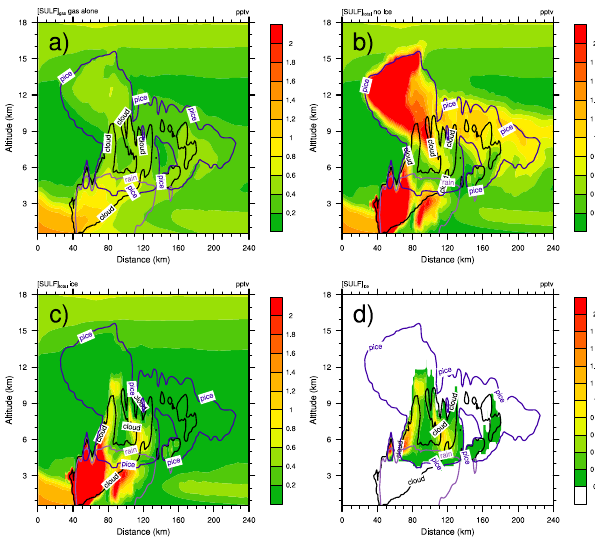
Figure 10. COPT case: same as Figure 7 but for sulphuric acid. 2 Fig. 10. COPT case – same as Fig. 7 but for sulphuric